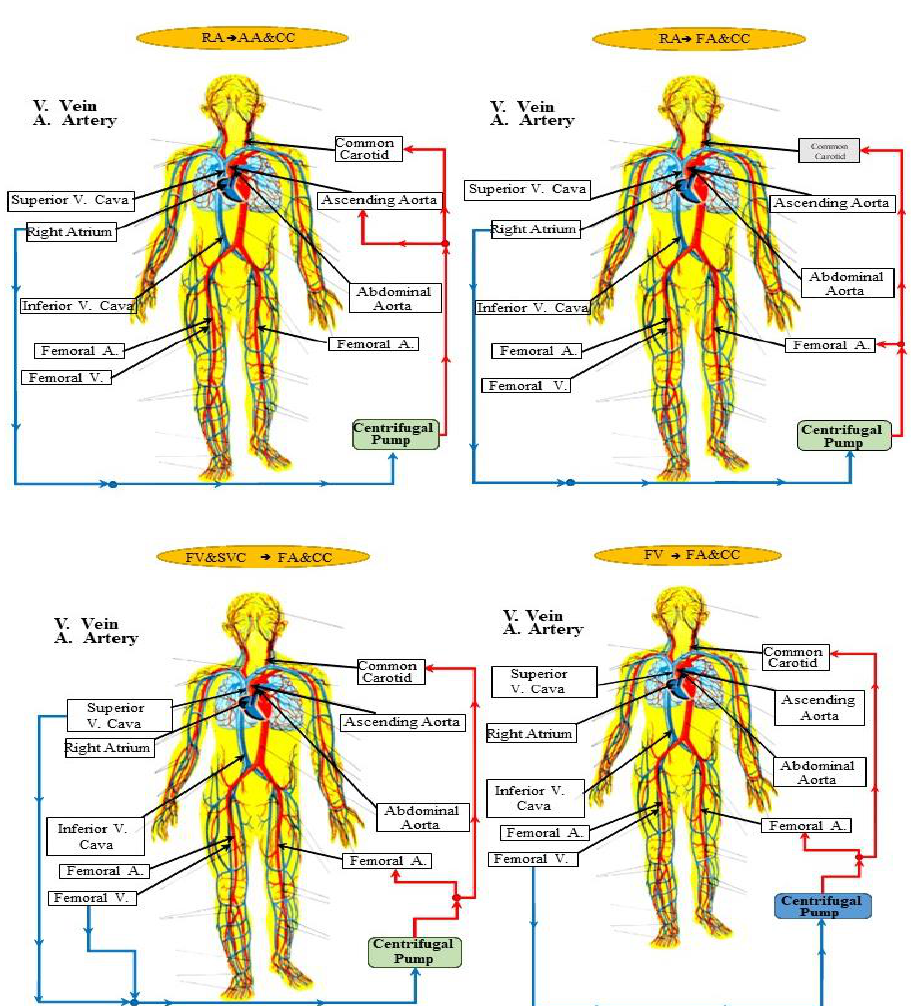
Figure 1. Schematic representation of the four cannulation strategies: right atrial to ascending aorta and bilateral common carotid artery return ( top left ); right atrial to femoral artery and bilateral common carotid artery return ( top right ); femoral vein and SVC to femoral artery and bilateral common carotid artery return ( bottom left ); and femoral vein to femoral artery and bilateral common carotid artery return ( bottom right